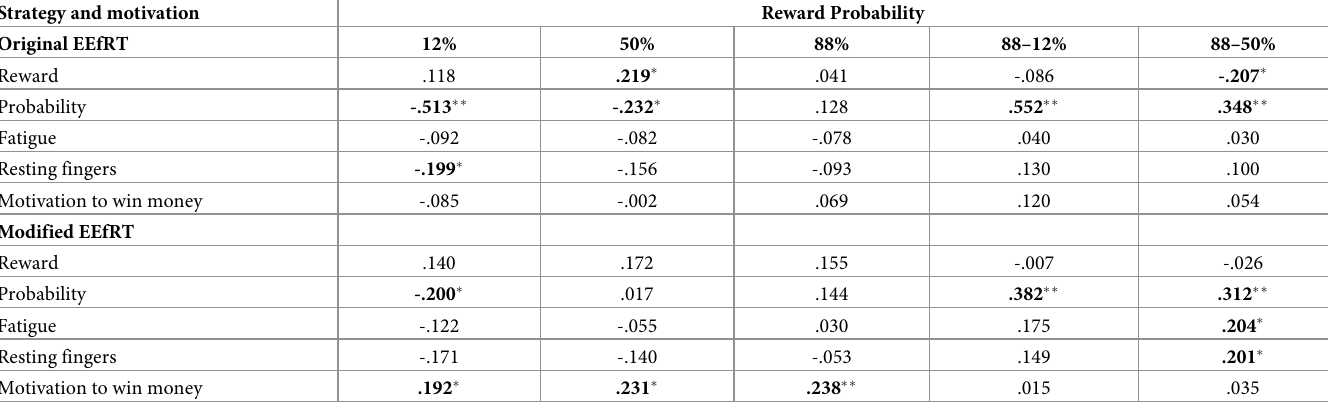
Table 7. Zero-order correlations between the original EEfRT (percentage of hard-task -choices), the modified EEfRT (mean number of clicks) and follow-up ques- tions concerning task strategy and motivation in Study 1 for different probabilities of reward attainment. Strategy and motivation Reward